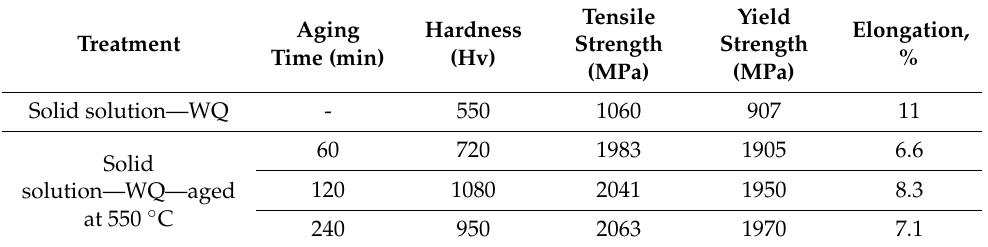
Table 3. Tensile properties M9.8 sample at solid solution annealing followed by WQ.